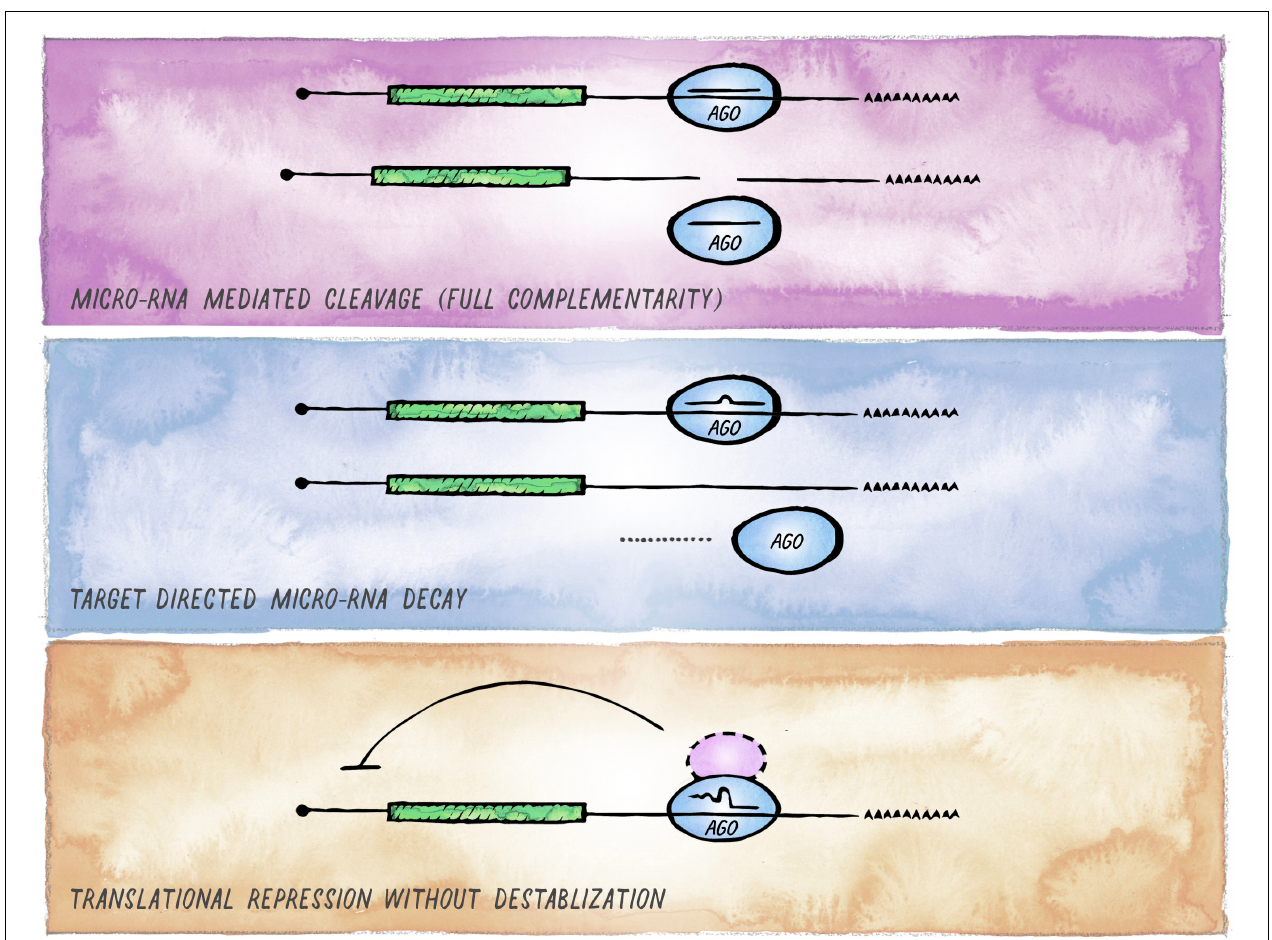
FIGURE 4 | Alternative outcomes of miRNA-mediated targeting. In addition to the common miRISC effects on translation and stability of target mRNAs, other functional outcomes of miRISC binding to an mRNA are possible. (A) Full sequence complementarity results in Ago-mediated target cleavage, a mechanism that resembles the mode of action commonly employed in cnidaria and plants. (B) Target-mediated miRNA degradation is induced by interaction with targets through extensive pairing, in particular extending to the miRNA 3 (cid:48) end. (C) Recruitment of Argonaute in the absence of GW182 results in inhibition of translation without affecting mRNA stability (likely involving alternative